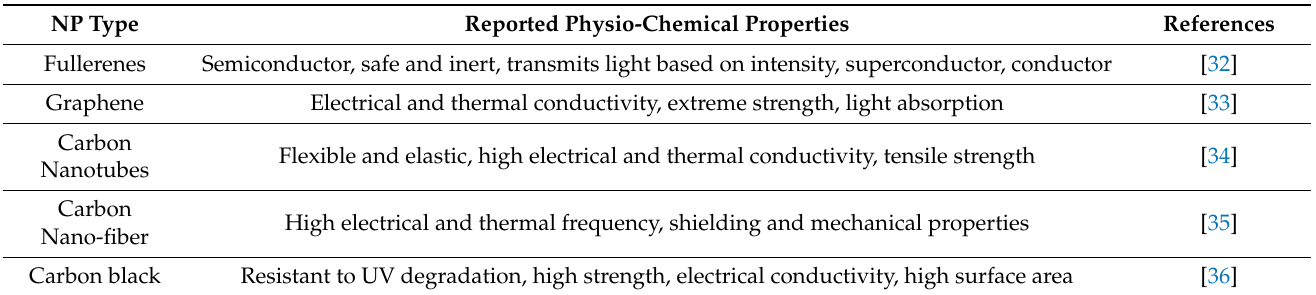
Table 3. Classification of carbon-based NPs and their physio-chemical properties.